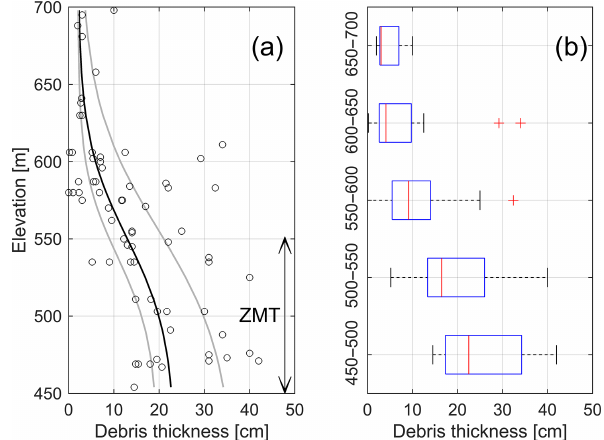
Figure 5. Debris thickness measurements for the five central me- dial moraines. (a) Debris thickness measurements as they vary with elevation (also see Fig. S14). The points plotted are the mean- measured debris thicknesses with symmetrical uncertainties around them. Curve fits through the median debris thickness (bold line) and the 25% and 75% quartiles (grey lines) from 50m elevation bins are shown in (b) . The double-headed arrow represents the zone of maximum thinning. (b) Box plots of debris thickness binned in 50m elevation bands. The red bars are the median and the vertical blue bars are the 25% and 75% quartiles, respectively. Note the sigmoidal shape of debris thickness with elevation. See the Supple- ment for curve fits applied to the other medial moraines as well as an exploration of linear curve fits through the data (Figs. S14 and S18).